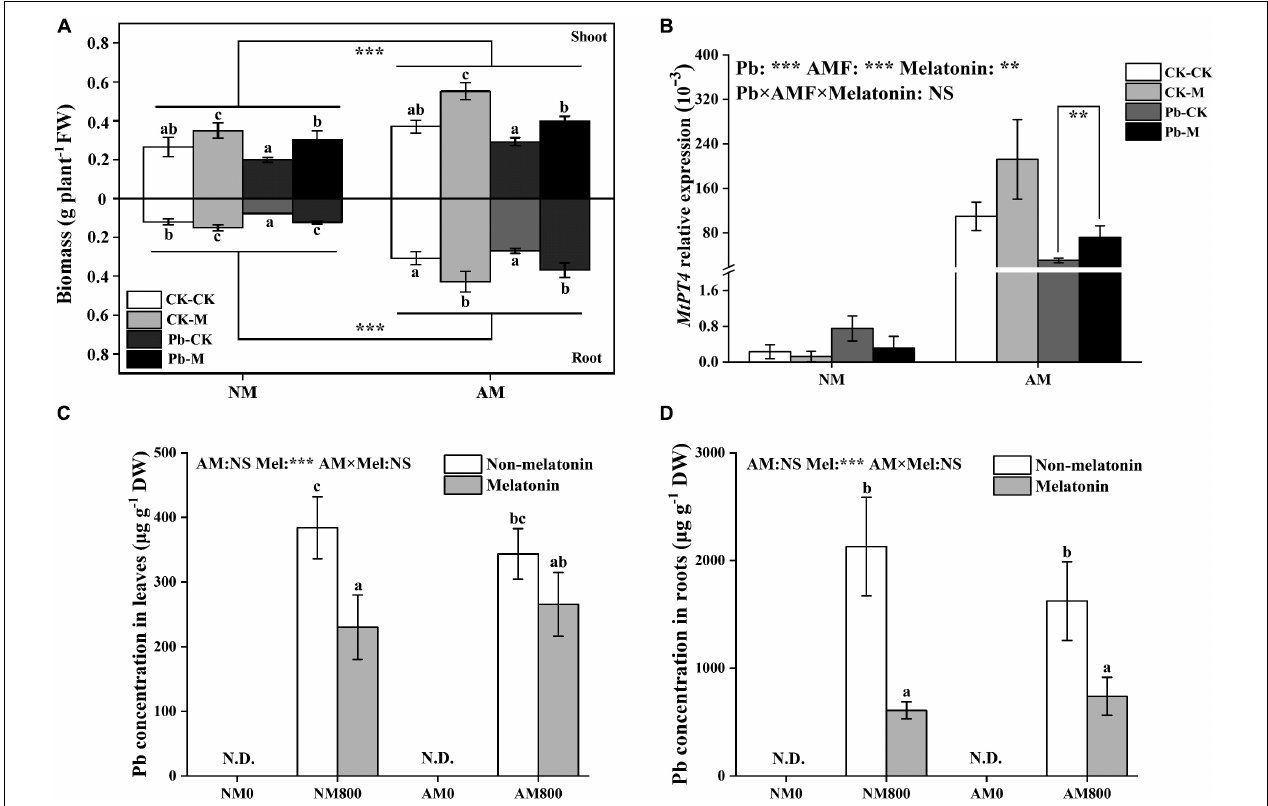
FIGURE 3 | (A) The fresh weight both in shoots and roots of AM plants under Pb stress and melatonin application. The data are the means ± standard deviation ( n = 4). Significant difference between NM plants and AM plants were labeled followed by the effect of two-way ANOVA. CK-CK = absence of both Pb stress and melatonin application; CK-M = melatonin application without Pb stress; Pb-CK = Pb stress without melatonin application; Pb-M = presence of both Pb stress and melatonin application. (B) The relative expression of MtPT4 of AM roots under Pb stress and melatonin application. (C,D) The Pb content of AM plants under Pb stress and melatonin application. The data are the means ± standard deviation ( n = 4). Different letters above the columns indicate significant difference among the means by Tukey HSD’s test ( P < 0.05). ** P < 0.01, *** P < 0.001; NS, not significant. N.D. = not detect. Mel = melatonin application. The abbreviation is consistent with the above.